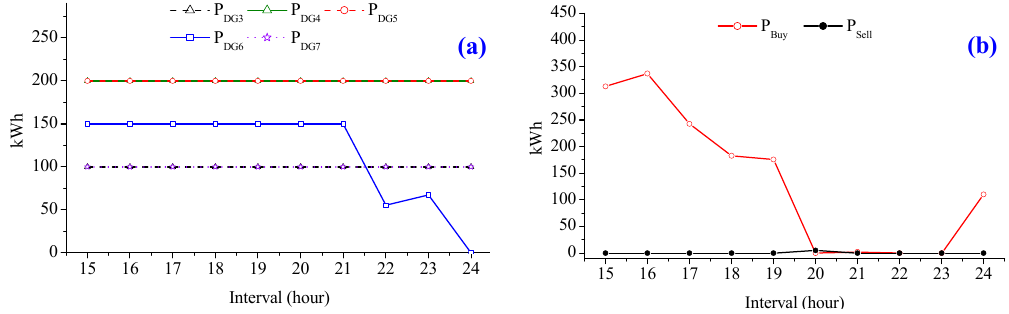
Figure 16. Operation results of normal part: ( a ) output power of DG units; and ( b ) the amount of exchanging power.